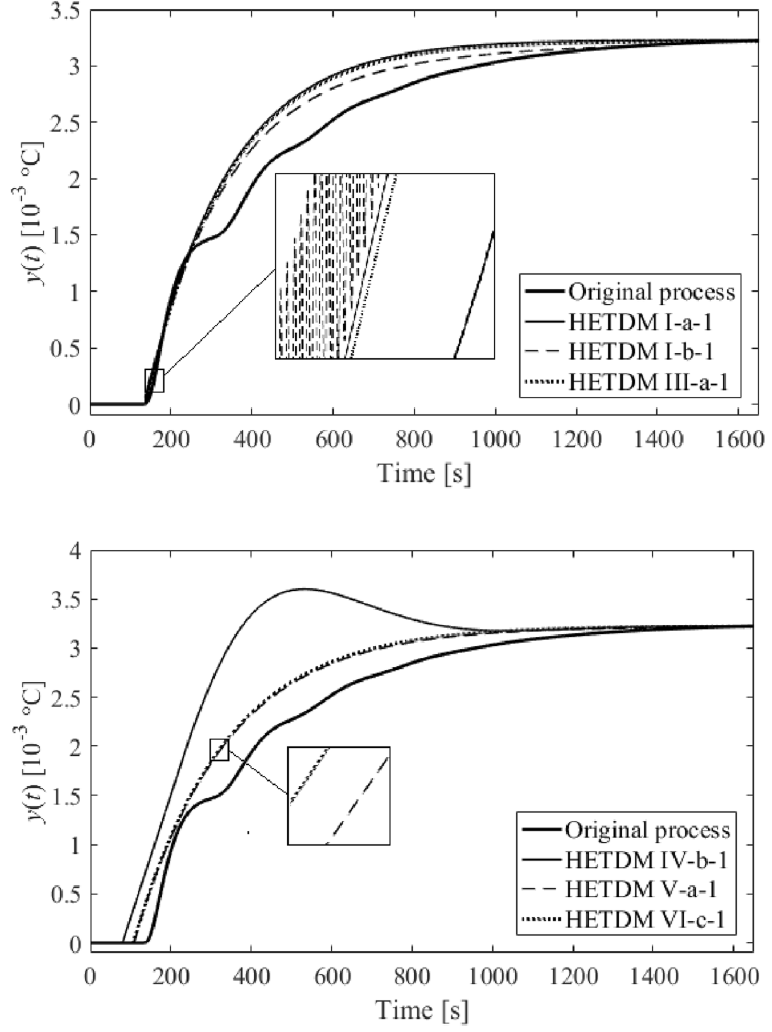
Figure 12. Comparison of selected HETDM unit step responses (vs. the original process response)—LM method used for transfer function numerator parameters